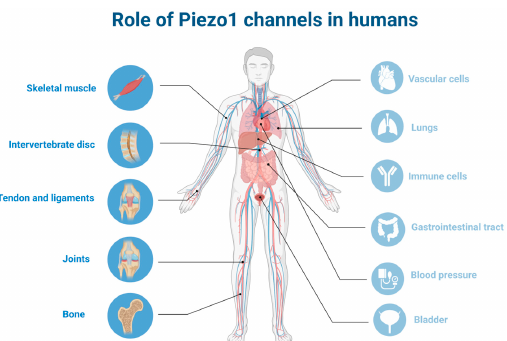
Figure 1. Role of Piezo1 channels in humans: localization of Piezo1 in different organs focusing on musculoskeletal system (the figure was created using biorender.com, accessed on 23 March 2023.). 2. Mechanosensation—Mechanosensitive and Mechanically Activated Channels The conversion of mechanical stimuli from the external or internal environment of cells into biological responses, i.e., mechanotransduction, is of fundamental importance both during tissue development and in the physiological processes of mature individuals.